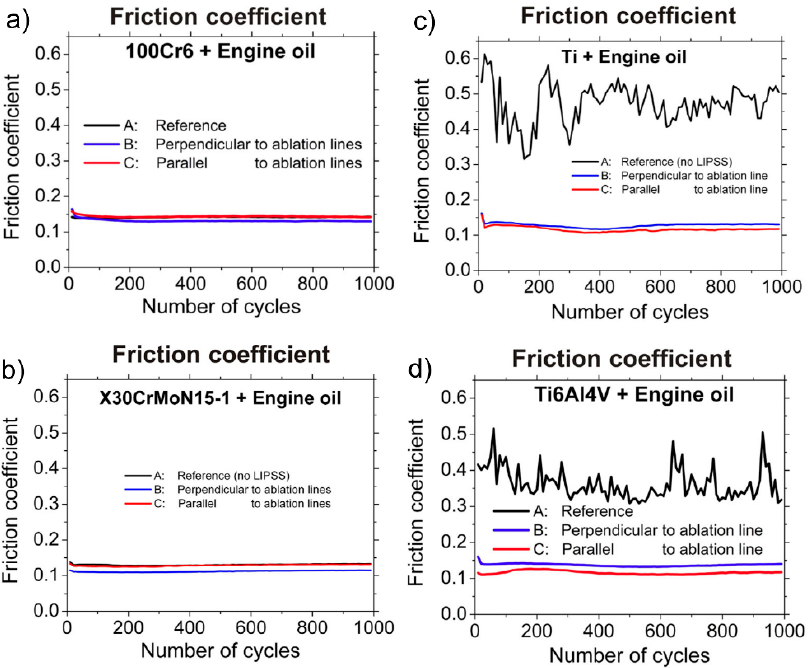
Figure 19. Friction coefficient µ as a function of the number of cycles as obtained during reciprocal sliding (normal force 1 N, stroke 1 mm, frequency 1 Hz) of fs-laser structured surfaces in engine oil against a 100Cr6 steel ball: ( a ) 100Cr6; ( b ) X30CrMoN15-1; ( c ) pure titanium; and ( d ) Ti6Al4V. ( a , d ) Adapted from Bonse et al . [13], with permission of Springer; ( b , c ) Reprinted from Bonse et al . [146], Copyright 2015, with permission from Elsevier.